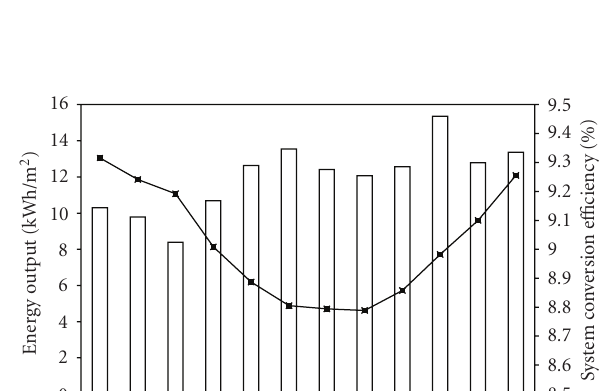
Figure 7: Monthly solar radiation on inclined surfaces.